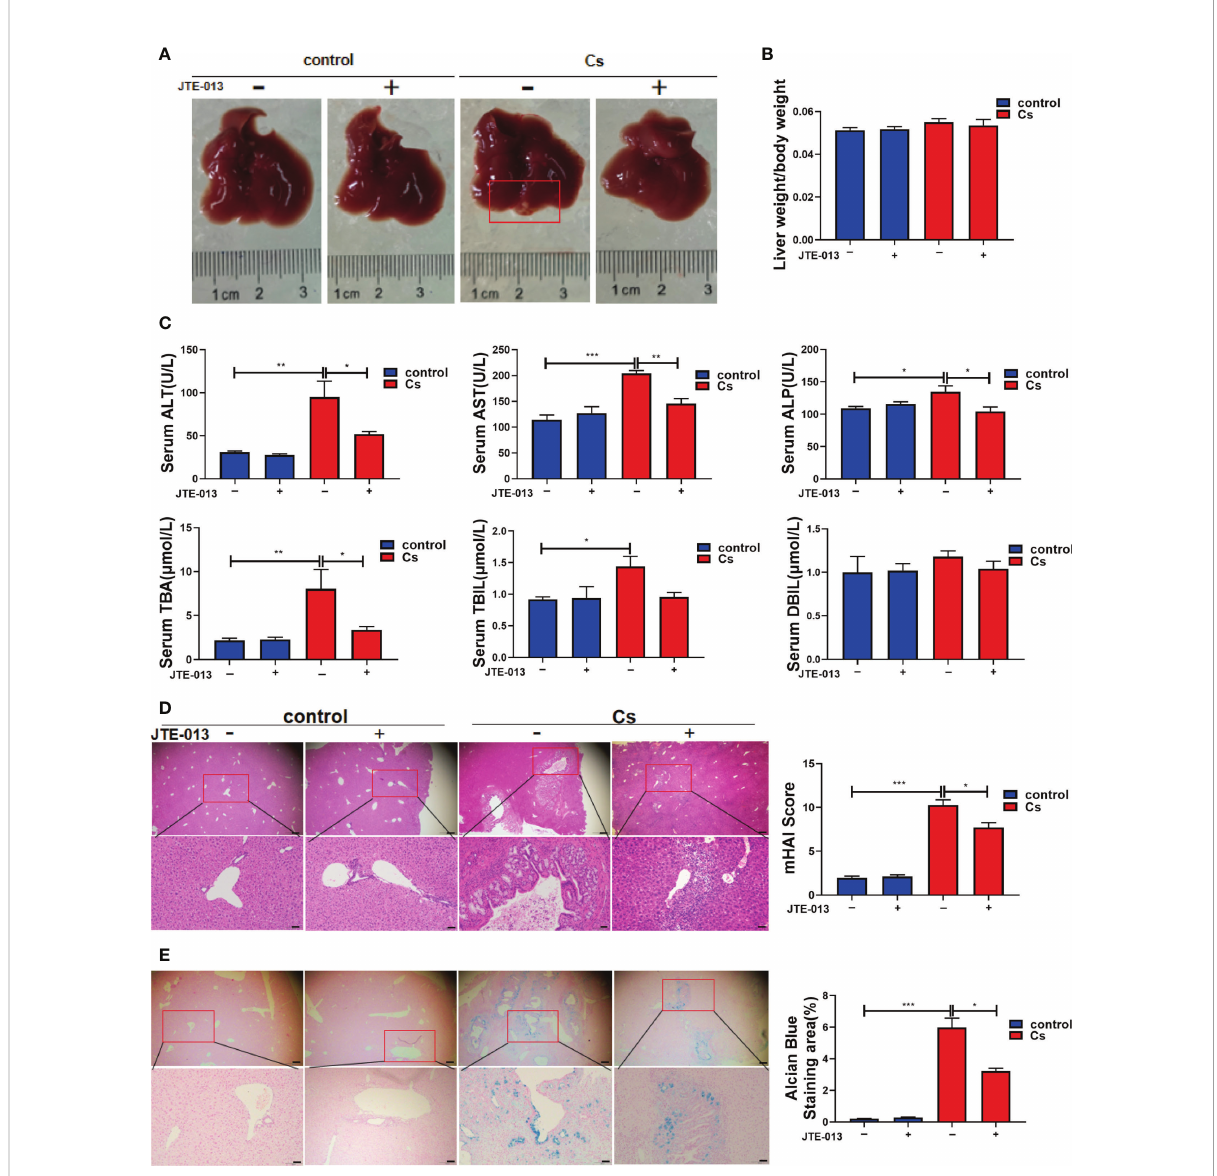
FIGURE 4 Inhibition of S1PR2 alleviated hepatobiliary damage in C. sinensis -infected mice. (A) The images of hepatobiliary injury in control and C. sinensis - infected mice. (B) The liver weight/body weight ratio in control and C. sinensis -infected mice. (C) The serum analysis of AST, ALT, ALP, TBA, DBIL, and TBIL in control and C sinensis -infected mice. (D) The H&E analysis the damage in hepatobiliary tissue of control and C. sinensis - infected mice under 40× and 200× microscope. (E) The Alcian Blue analysis the damage in hepatobiliary tissue of control and C. sinensis - infected mice under 40× and 200× microscope. Compared with indicated groups, * P <0.05, ** P <0.01, *** P